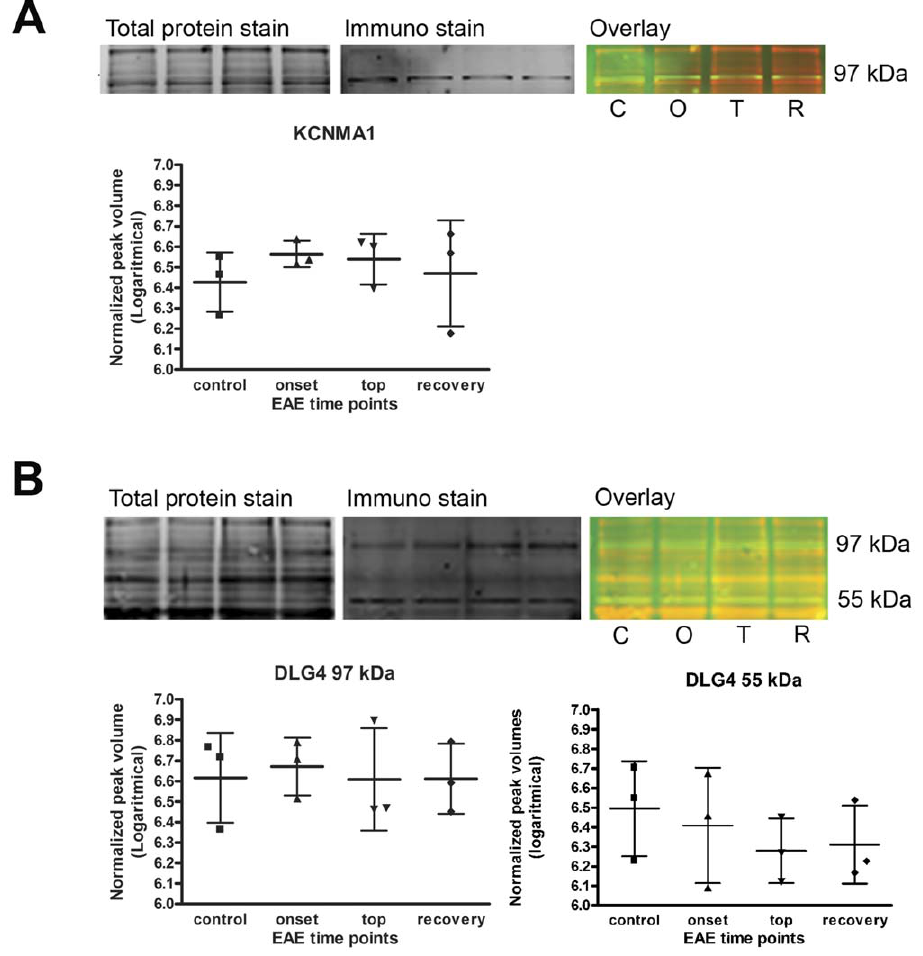
Figure 9. Western blot analysis of DLG4 and KCNMA1. A quantitative fluorescent western blot was performed to analyze the presence and expression levels of KCNMA1 (Panel A) and DLG4 (Panel B). By means of peak detection, the normalized peak volumes were used for quantification. No significant difference was found in expression levels, but both proteins were detected in the samples of the 2D-DIGE experiment. All animals were included in the WB analysis; control (C), onset (O), top (T) and recovery (R).